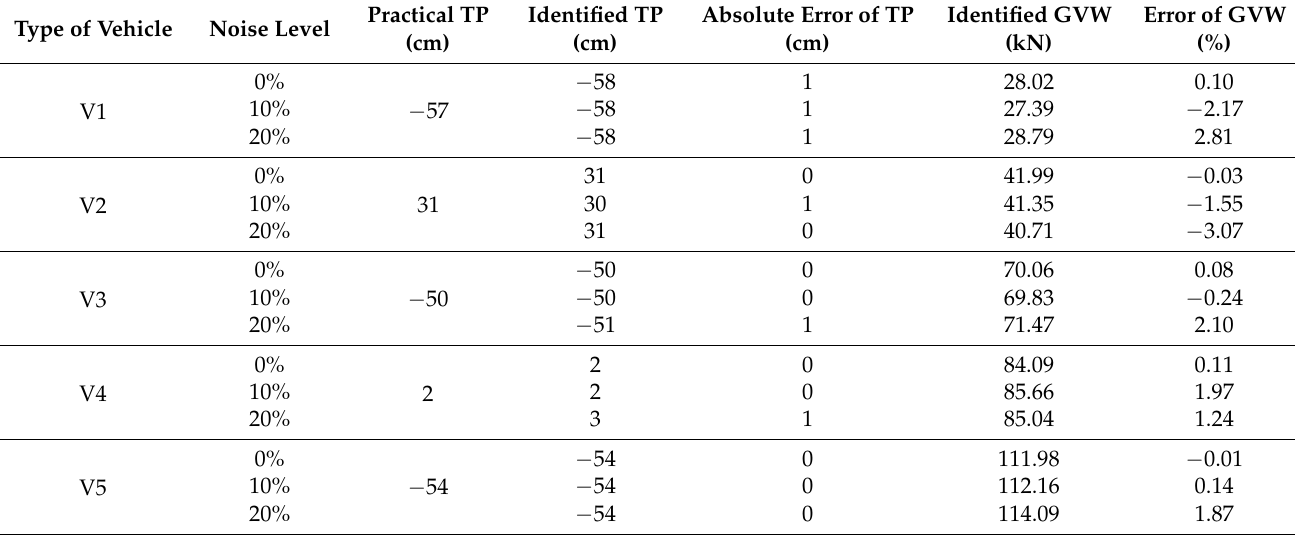
Table 3. Load identification of vehicles on each